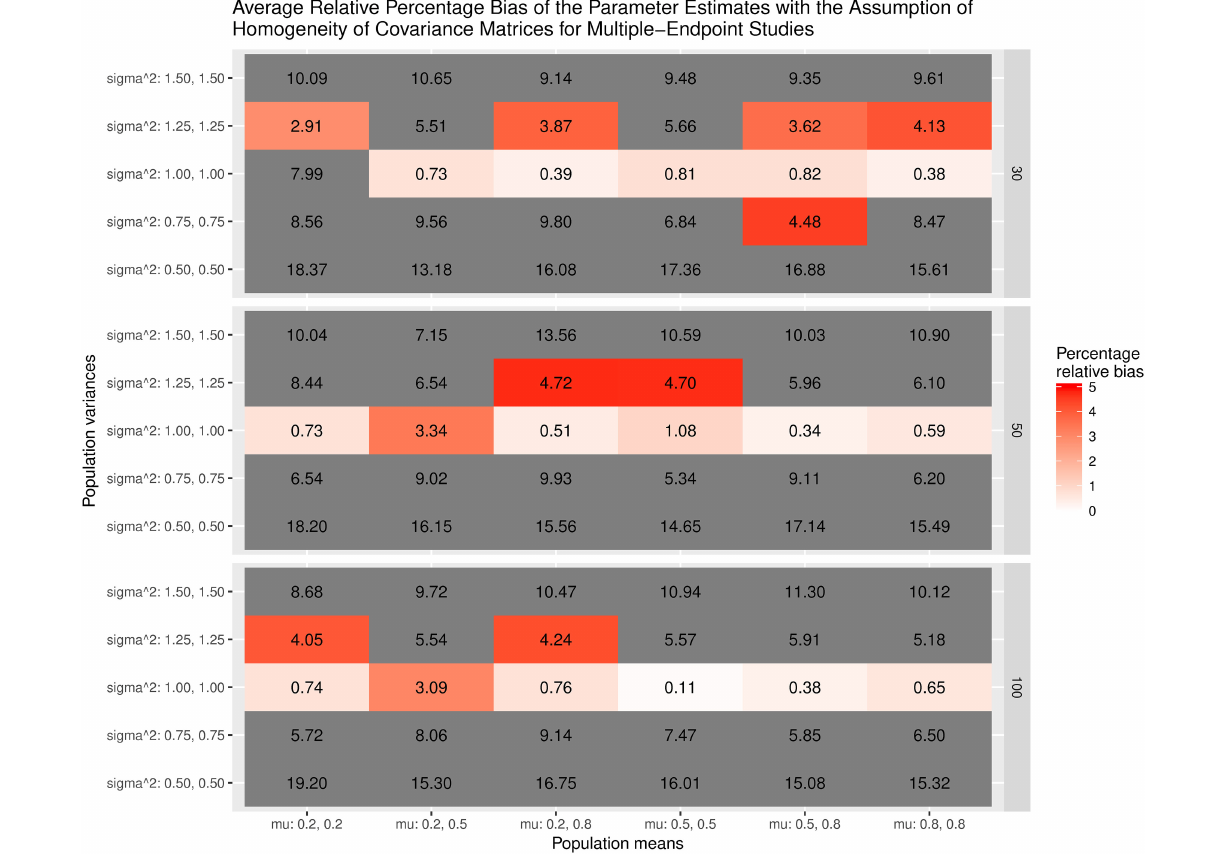
Frontiers in Psychology |